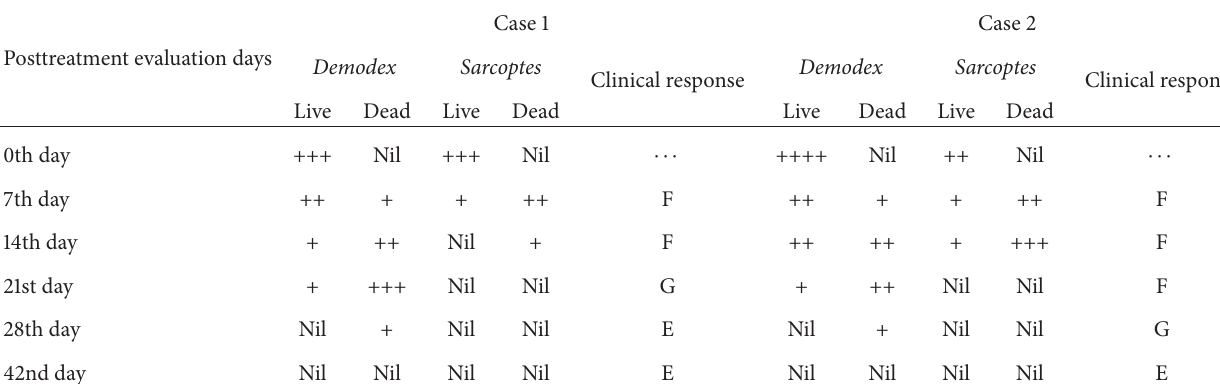
Table 1: Therapeutic response to ivermectin in both the